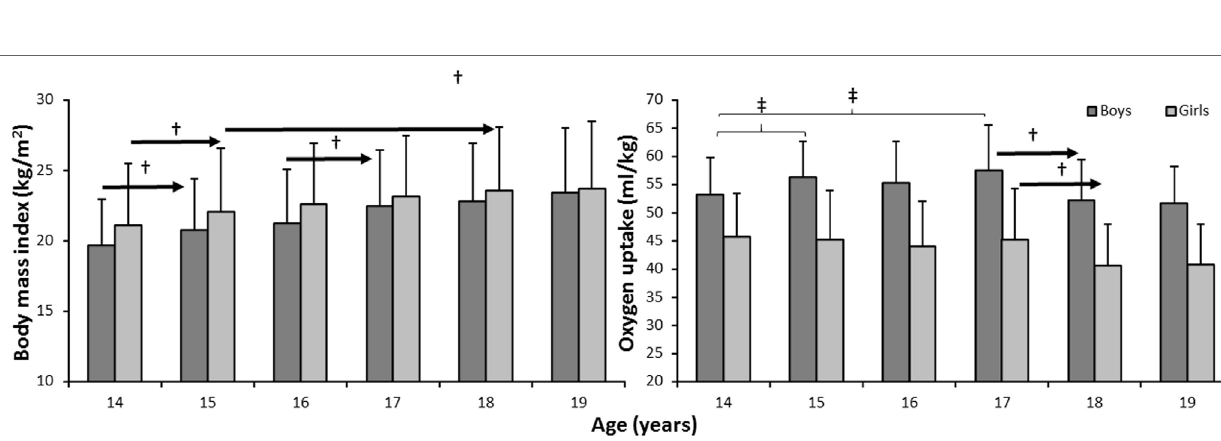
FigUre 3 | Proportion of students physically active during school breaks by gender and year (boys: n = 28, girls: n = 14). * indicates a significant gender difference at this age at a p < 0.05 level. † indicates a significant difference between this age and a later age at a p < 0.05 level, as indicated by the right-pointing